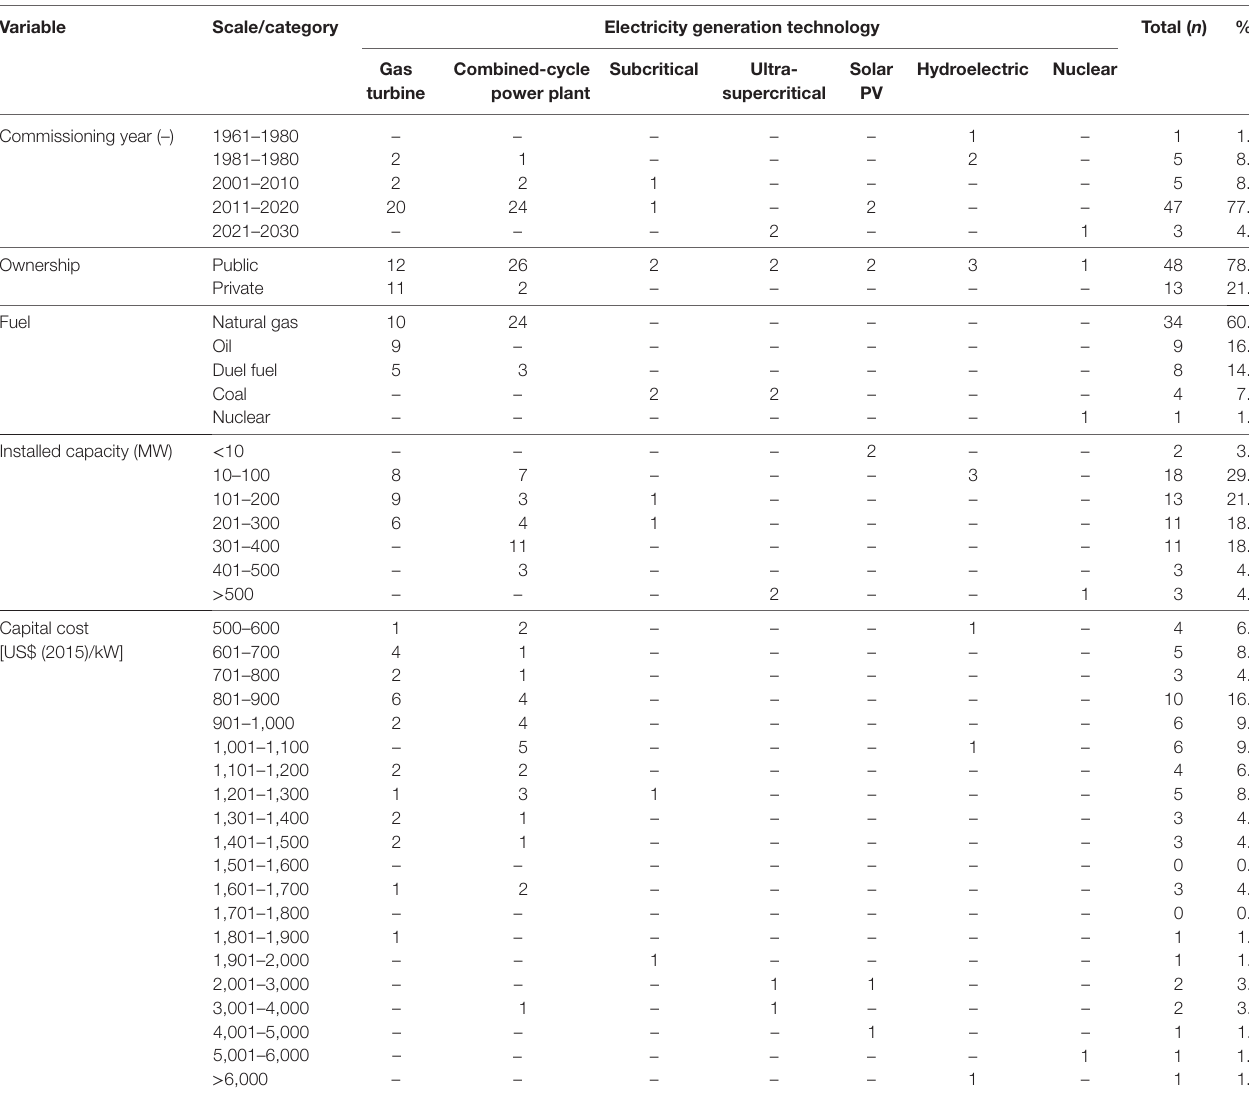
taBLe 1 | Background information on the cost